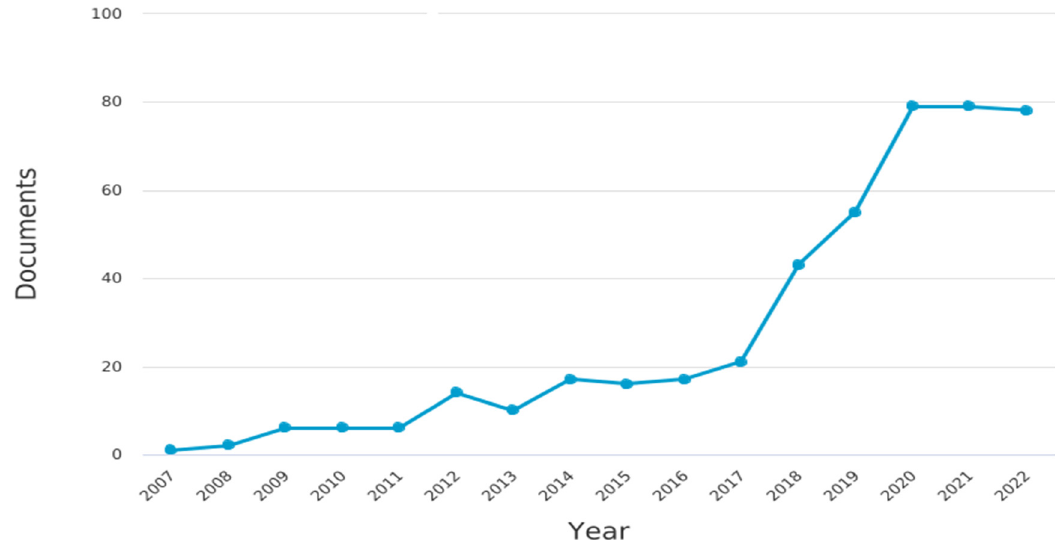
Figure 1. Document publications from 2007 to 2022.